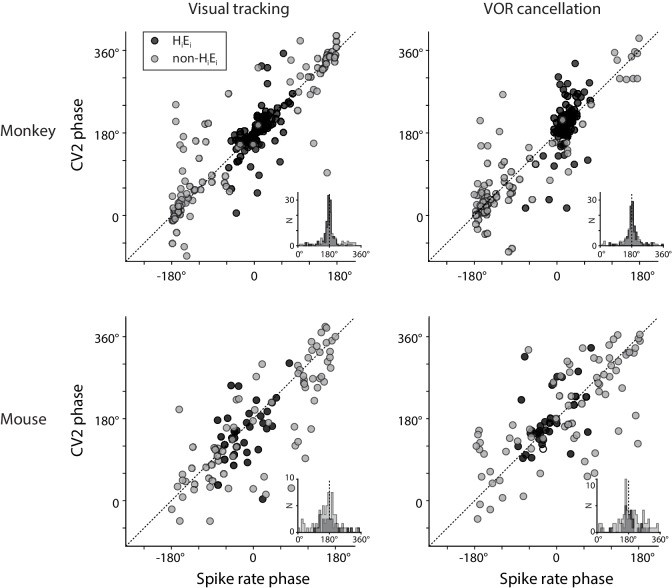
Relationship between spike rate and irregularity for all Purkinje cells.Left, the phase of peak spike irregularity (CV2) (ordinate), compared with the phase of peak spike rate in the same Purkinje cell (abscissa) during visual tracking, with phase of CV2 and spike rate each measured relative to peak ipsiversive eye velocity. Positive numbers represent a phase lead. Right, the phase of peak spike irregularity (CV2) and spike rate in each Purkinje cell during VOR cancellation, with phase measured relative to peak ipsiversive head velocity. Each point represents the result from a single Purkinje cell recorded in monkeys (top) or mice (bottom). The EiHi Purkinje cells (filled circles, n = 120 monkey; n = 33, mouse) were defined as having a spike rate phase within ±90° of zero during both visual tracking and VOR cancellation. Other Purkinje cells had different spike rate phases (open circles, n = 102, monkey; n = 77, mouse). Insets, histogram of the difference between CV2 phase and spike rate phase. Across all Purkinje cells, peak CV2 was roughly 180° out of phase with peak spike rate.